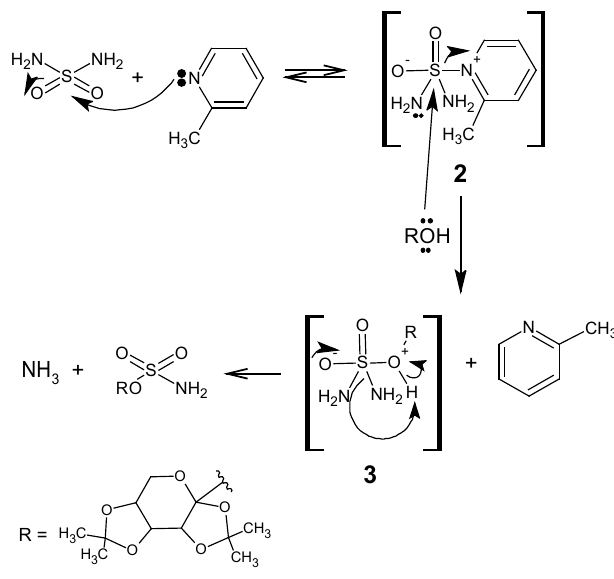
Fig. 3. The Proposed mechanism for topiramate